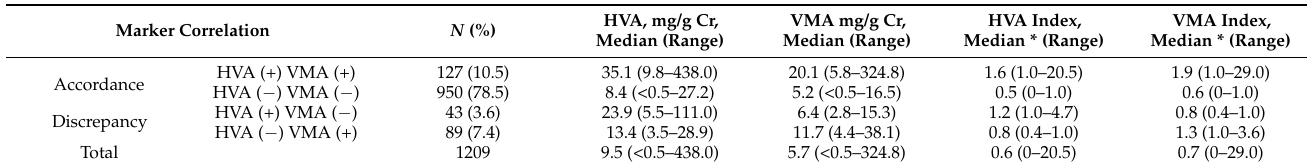
Table 2. HVA and VMA measurements in combination for detection and monitoring of